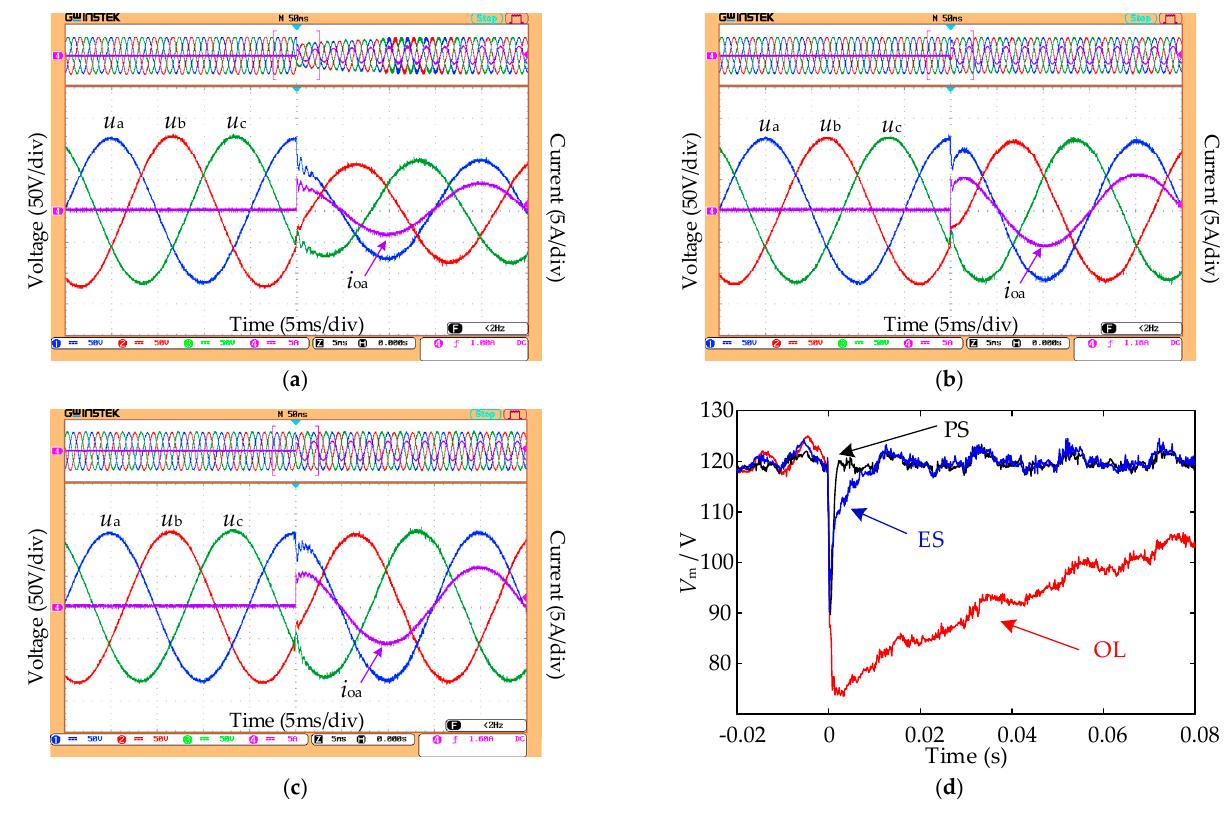
Figure 15. Experimental results under load switching. ( a ) Original LADRC scheme; ( b ) Proposed scheme; ( c ) Estimated load current scheme; ( d ) Amplitude of different schemes. Table 5. THD (%) values under different schemes in the